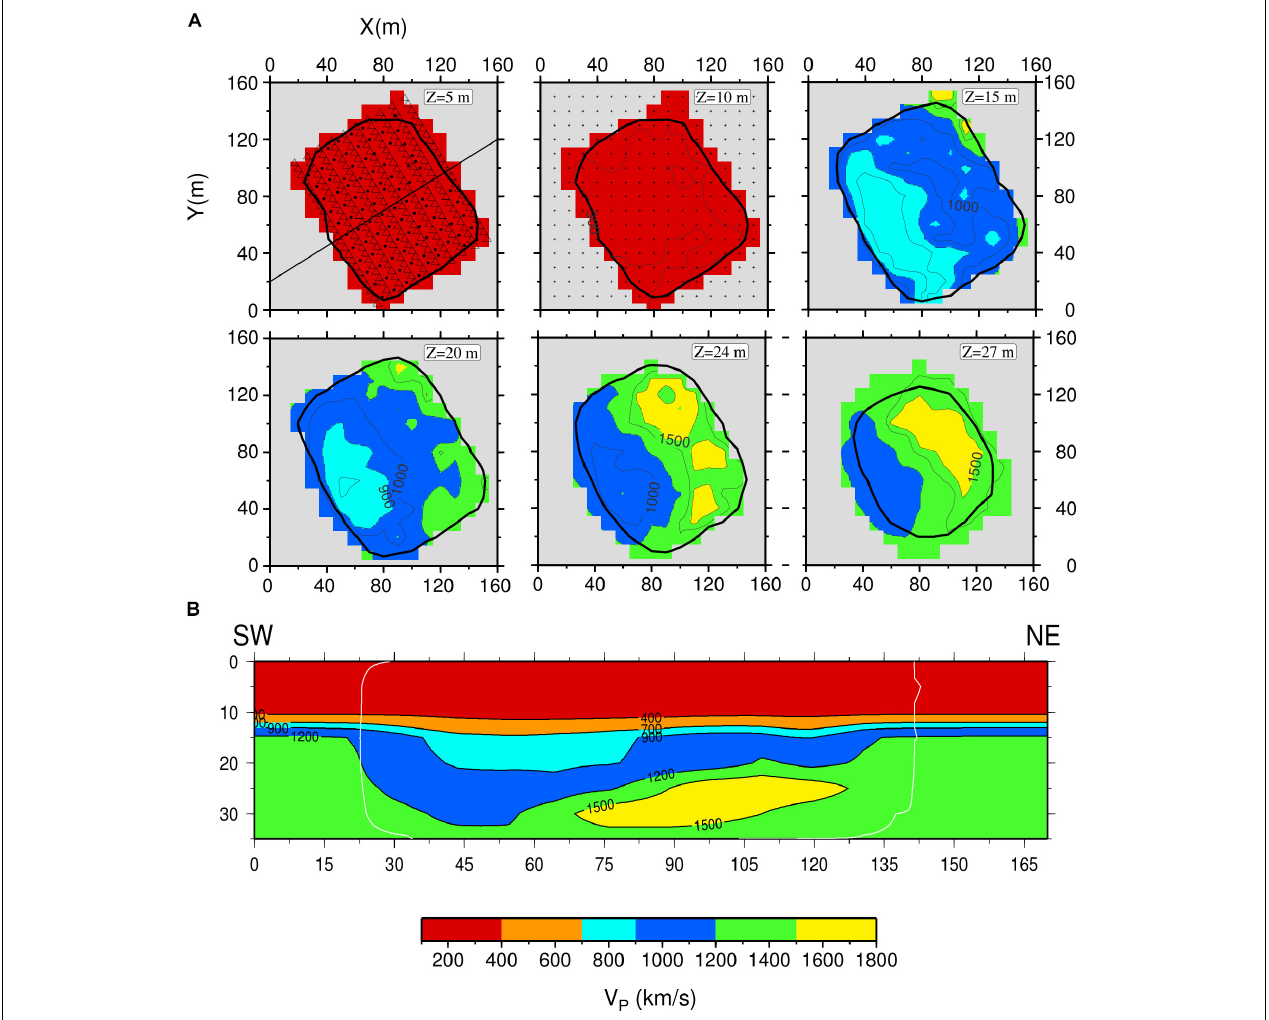
FIGURE 7 | P-wave velocity model. (A) Horizontal slice of P-wave velocity model at different depths. The black contour delimitates the resolved area, i.e., the area for which the three resolution parameters (RDE, Sj, and DWS ) are included in a threshold value. The threshold values of S j and DWS are chosen in order to obtain a similar contour, binding the RDE to be higher than 0.9. The gray regions in each slice represent areas not covered by rays. (B) P-wave velocity model projected onto the NE-SW cross-section located in (A) . The white contour delimitates the resolved area. Modified after De Landro et al.